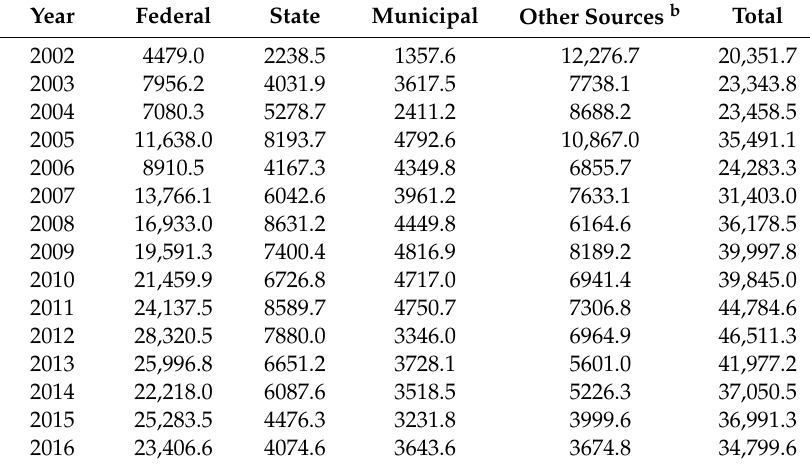
Table 1. Total investments by sector of origin of the resource, 2002 to 2016 a (in Millions, $MX of